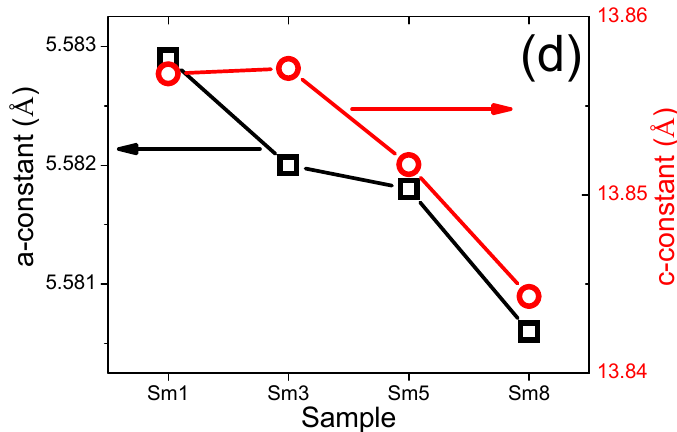
Figure 5. ( a ) XRD diffraction patterns, ( b ) enlarged view of the (110) peaks, ( c ) Rietveld refinement results of the Sm8 sample, ( d ) calculated lattice constants (a and c) of the Sm-doped BFO samples